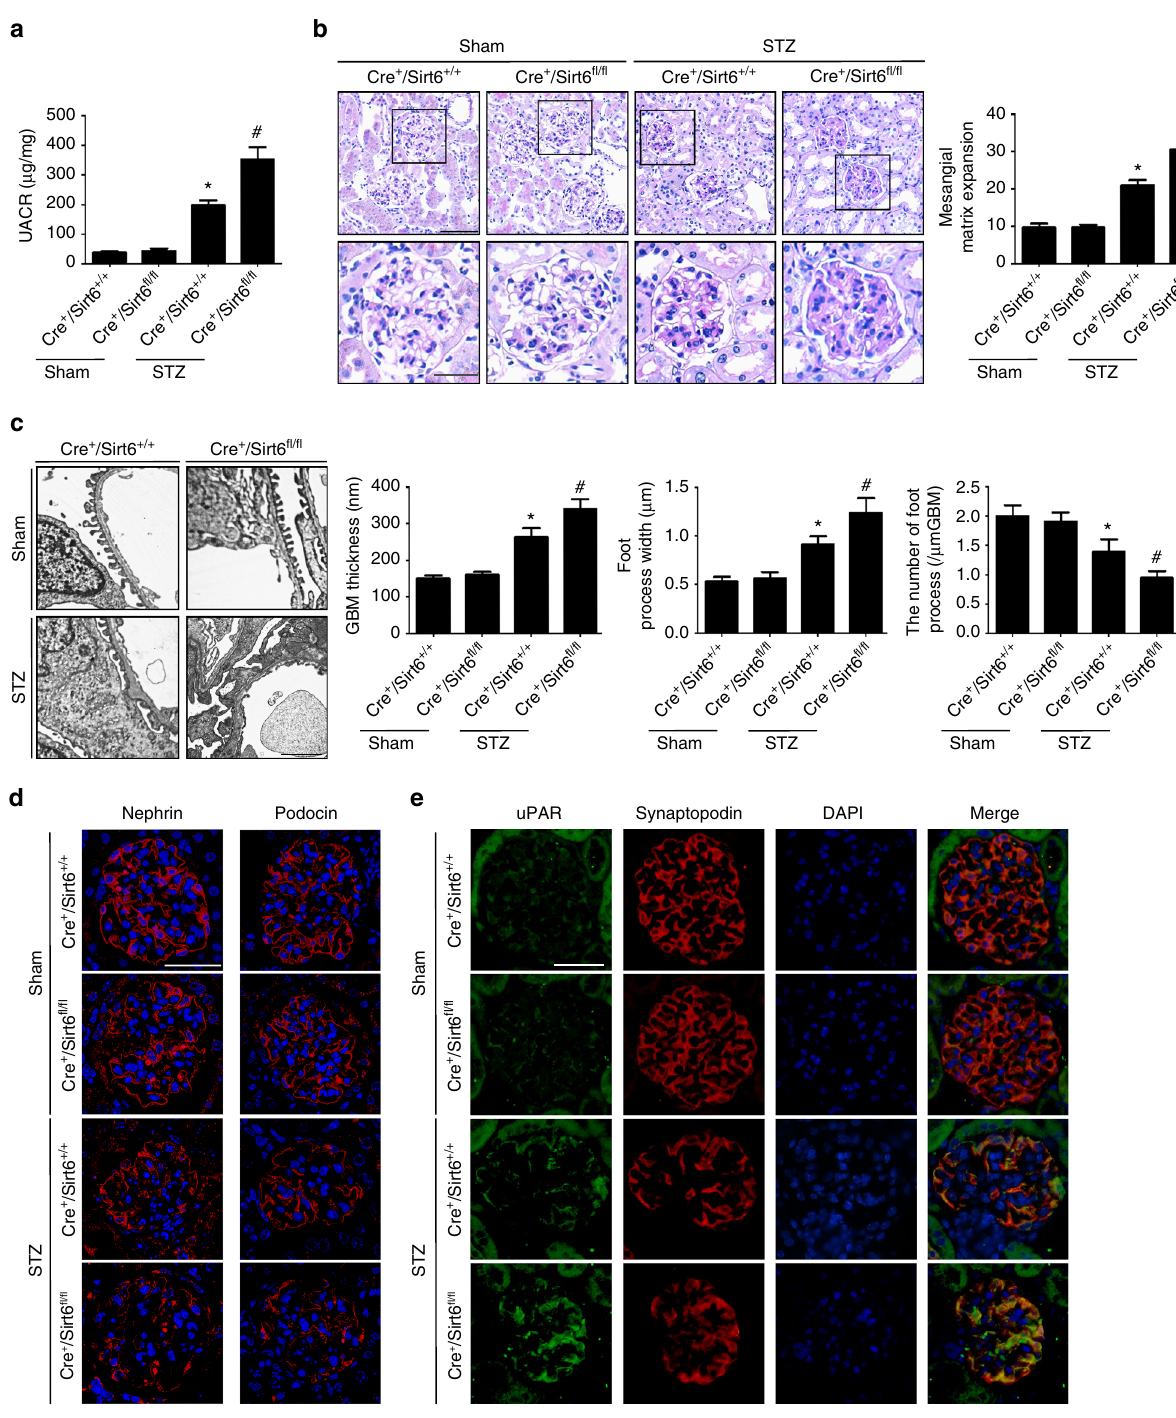
Fig. 4 Podocyte-speci fi c loss of Sirt6 exacerbates podocyte injury and proteinuria in DN. a UACR (urine albumin-to-creatinine ratio) in different groups of mice. b Photomicrographs and quanti fi cations showing typical glomerular structure changes in different groups of mice. Scale bar : black 50 μ m, red 25 μ m. c Representative photomicrographs and quanti fi cations of mean glomerular basement membrane (GBM) thickness, mean foot process width, and the number of foot processes in different groups of mice at different age by transmission electron microscopy (TEM) analyses. Scale bar , 3 μ m. d Representative confocal microscopic images showing the expressions of nephrin and podocin in the kidney from different groups of mice. Scale bar , 25 μ m. e Representative confocal microscopic images showing the expressions of uPAR in podocytes from different groups of mice. Scale bar , 25 μ m. Podocyte-speci fi c Sirt6 knockout mice: Cre + /Sirt6 fl / fl mice; Mice with two WT alleles and Cre expression ( Cre + /Sirt6 + / + ) were used as controls. * P < 0.05 vs. control ( Cre + /Sirt6 + / + mice), # P < 0.05 vs. Cre + /Sirt6 + / + STZ mice. ( n = 8.) Data are expressed as means ± SE. One-way ANOVA followed by Tukey ’